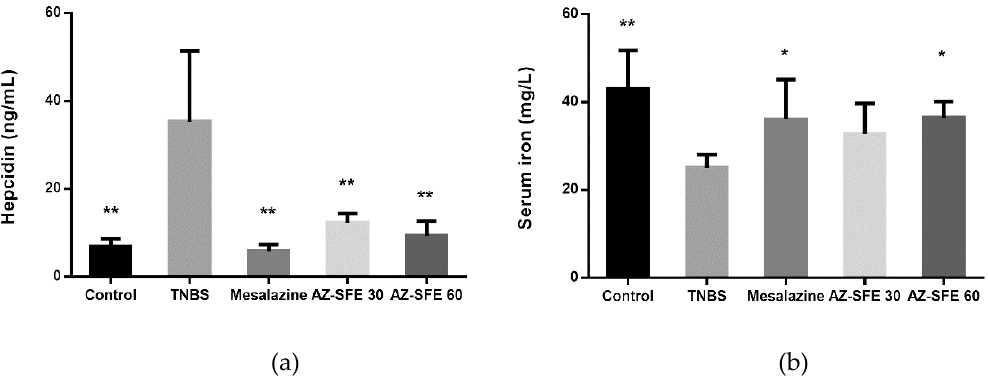
Figure 9. Effects of AZ-SFE (30 and 60 mg/kg) and mesalazine (400 mg/kg) on the levels of ( a ) serum hepcidin and ( b ) serum iron of TNBS-induced colitis in rats. Data are presented as mean ± SD of 6 rats per group. * p < 0.05 and ** p < 0.01 versus TNBS group.